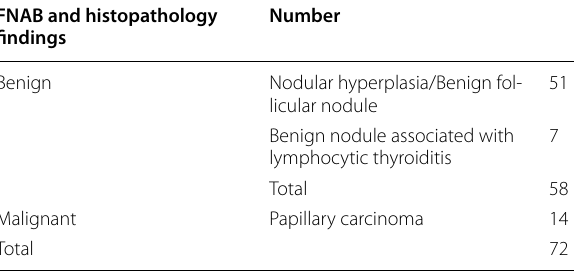
Table 1 FNAB and postoperative histopathology findings of thyroid nodules (n 72 nodules in 56 patients) = FNAB and histopathology